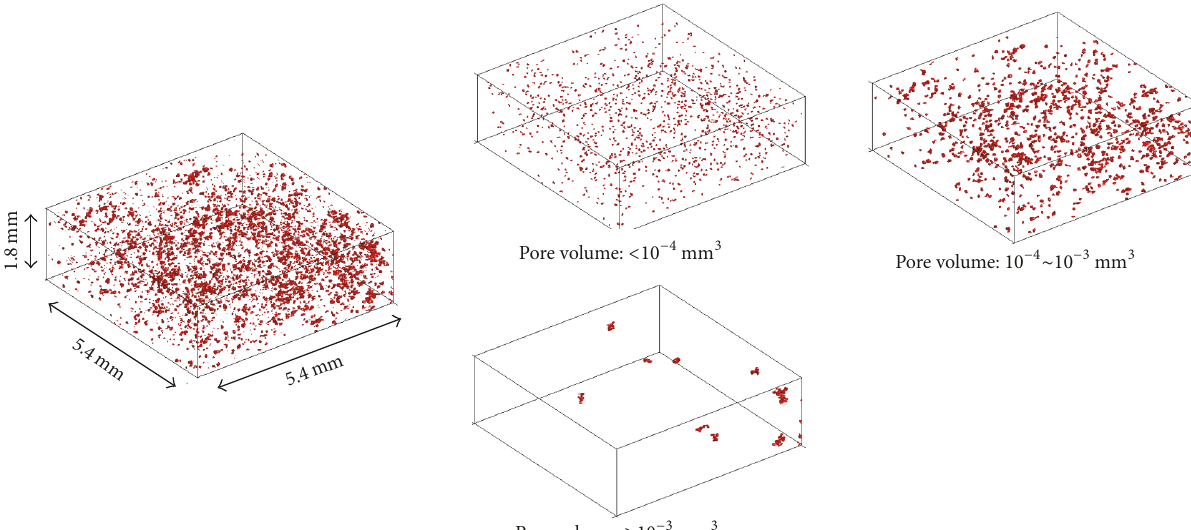
Figure 7: Reconstructed 3D micropore structure of the PC sample (separated micropores based on pore-volume